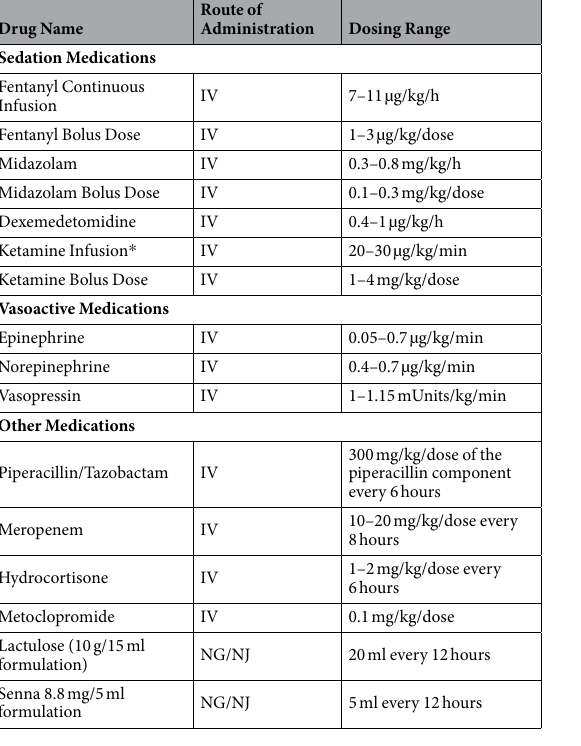
Table 4. Drug List and Dosing Range. * Long-term ketamine infusion is not recommended due to a tendency to induce an unstable dissociative effect rather than